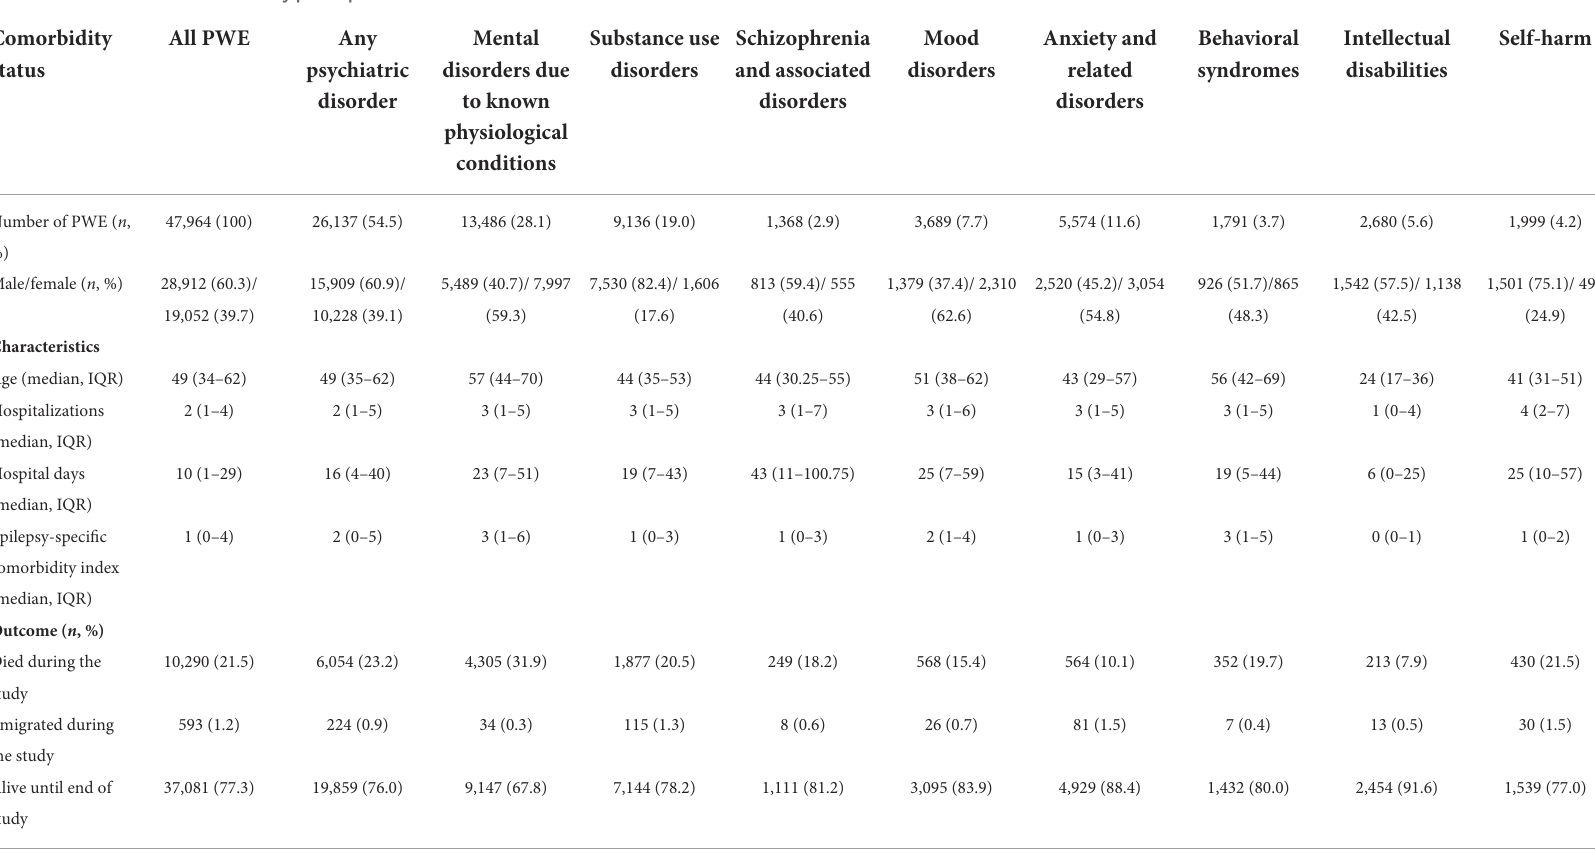
TABLE 1 The characteristics of study